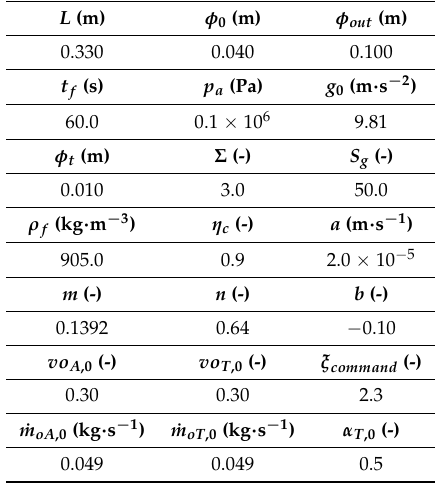
Table 4. Numerical simulations’